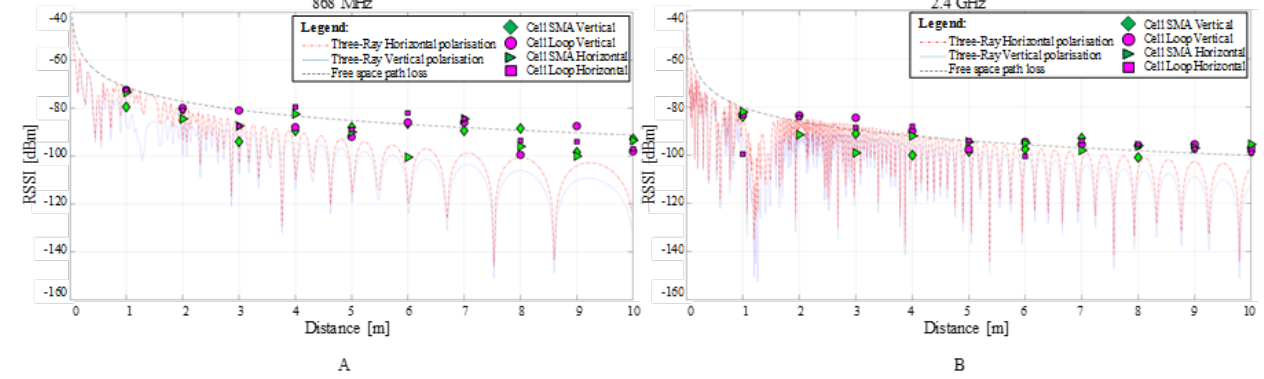
Figure 11. MATLAB signal attenuation simulation by using the Three-Ray and Free space models for 868 MHz ( A ), and 2.4 GHz ( B ), between the concrete ground.